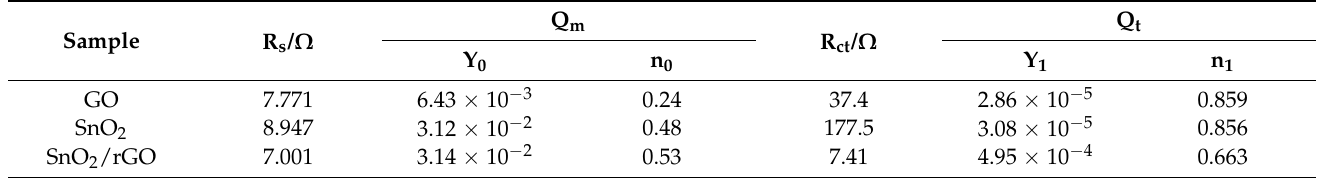
Table 1. Corresponding fitting electrochemical parameters for SnO 2 , GO, and SnO 2 /rGO. Sample